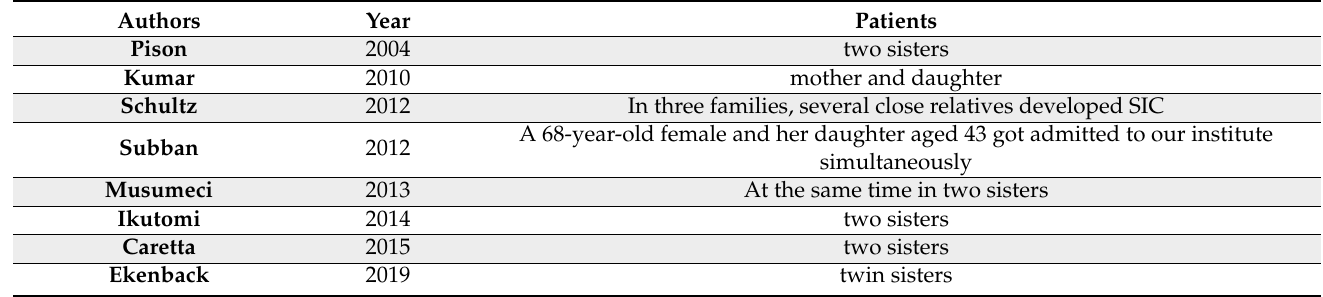
Table 1. Familial case of